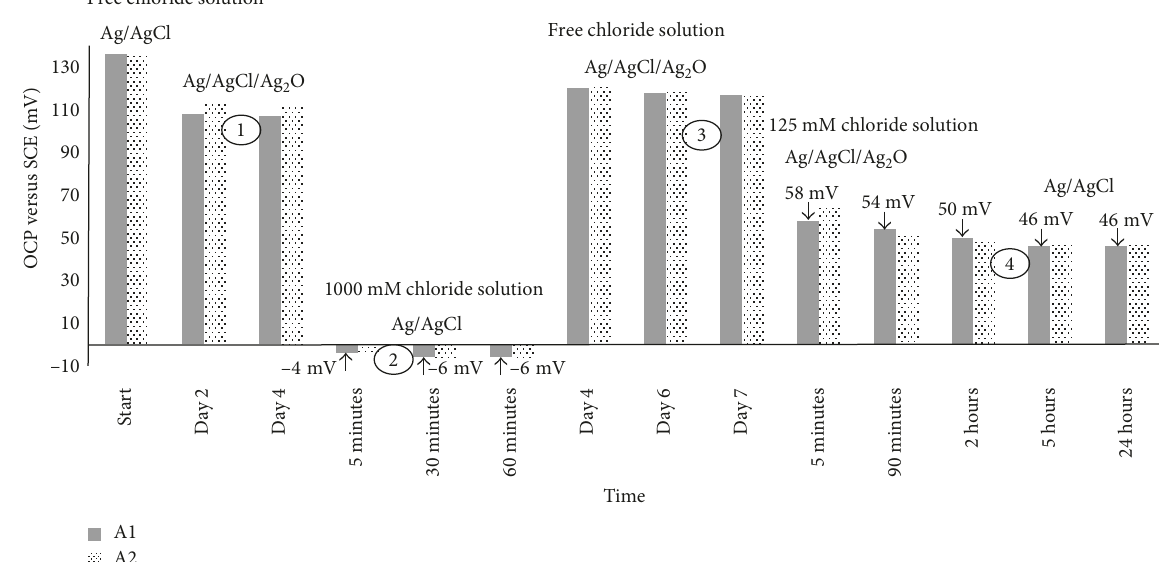
Figure 8: Sensor’s response in chloride-free and chloride-containing simulated pore solution